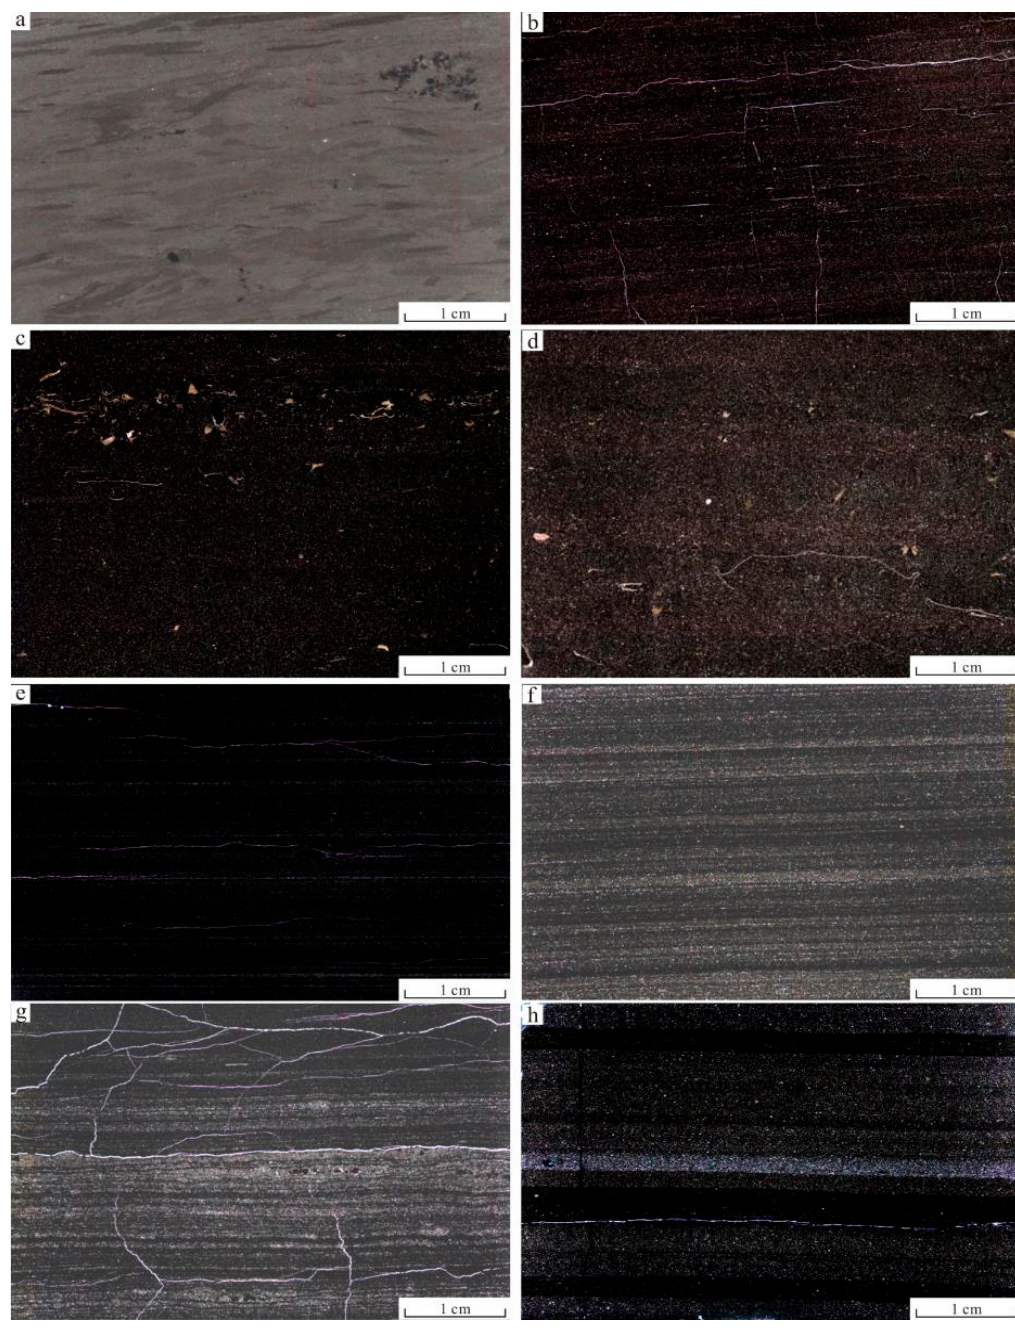
Figure 8. Typical sedimentologic characteristics of the Wufeng-Longmaxi shale on the Yangtze Platform, South China. ( a ) Bioturbated-type structureless beds, YH3–8, Wufeng Formation; ( b ) graded lamination composed of claystone, Chuanghe outcrop, Wufeng Formation; ( c ) massive-type structureless beds, Shuanghe outcrop, Guanyingqiao bed; ( d ) massive-type structureless beds, Shuanghe outcrop, Guanyingqiao bed; ( e ) paper lamination, Z204, Longmaxi Formation; ( f ) and ( g ) graded lamination composed of siltstone and claystone, N211, Longmaxi Formation; ( h ) interlaminated lamination composed of siltstone and claystone, Z204, Longmaxi Formation.